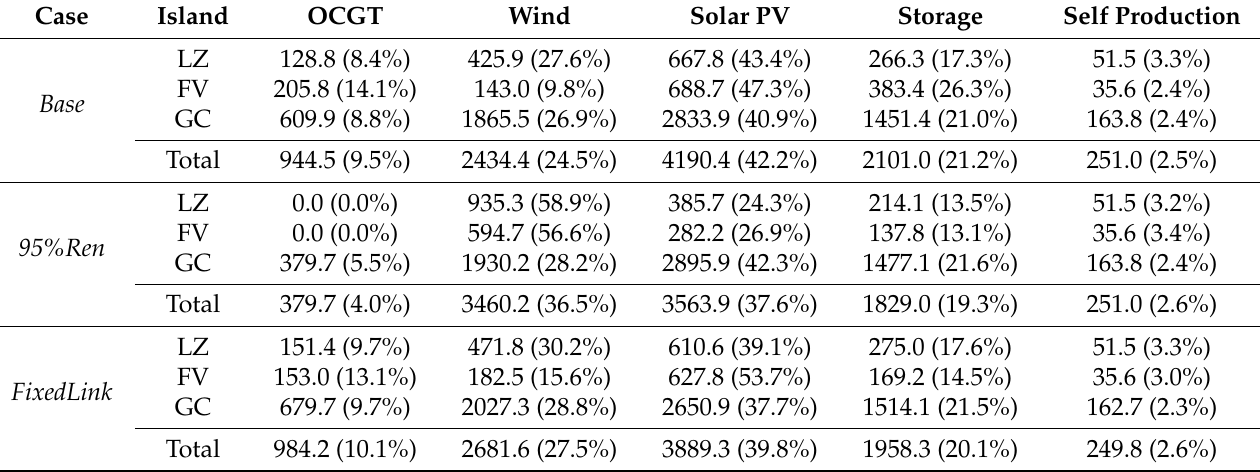
Table 15. Energy produced